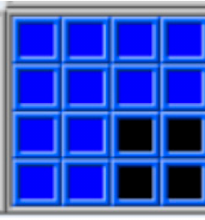
Figure 11. Diagram of the PVM’s solar cell array for shadow simulation through a single PVM simulator.